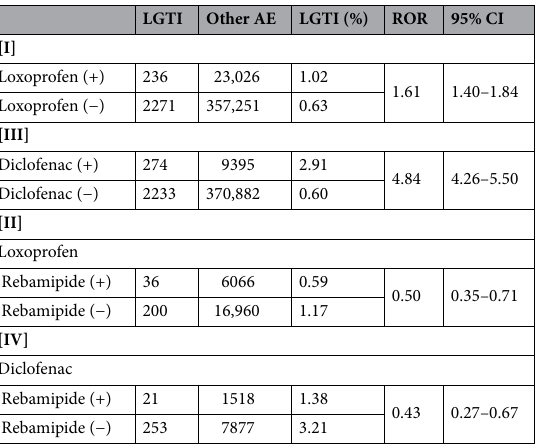
Table 2. Number of cases and ROR (95% CI) of each NSAID-induced lower gastrointestinal tract injury adverse event reported in JADER. Lower gastrointestinal tract injury of single-drug NSAIDs [I], [III]. Lower gastrointestinal tract injury with concomitant use of rebamipide and NSAIDs [II], [IV]. LGTI lower gastrointestinal tract injury, AE adverse